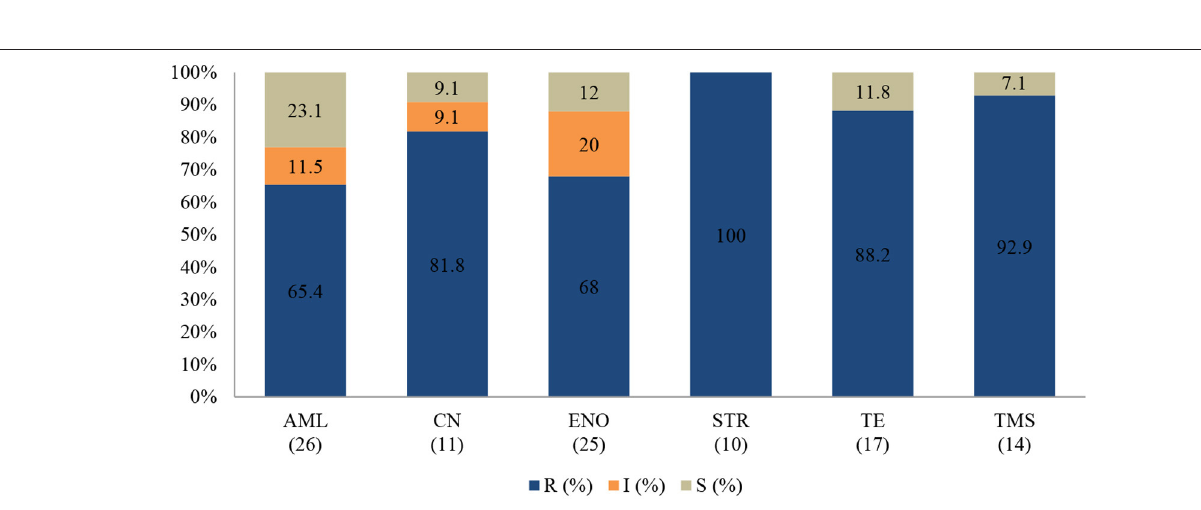
FIGURE 7 | Antibiotic susceptibility pattern of Staphylococcus spp. isolates from diseased non-ruminants (January 2015-December 2017). R-resistance; I-intermediate; S-susceptible; AML-amoxicillin; CN-gentamicin; ENO-enrofloxacin; STR-streptomycin; TE-tetracycline; TMS-trimethoprim/sulfamethoxazole; Numbers inside brackets “()” indicate total number of tested isolates for each